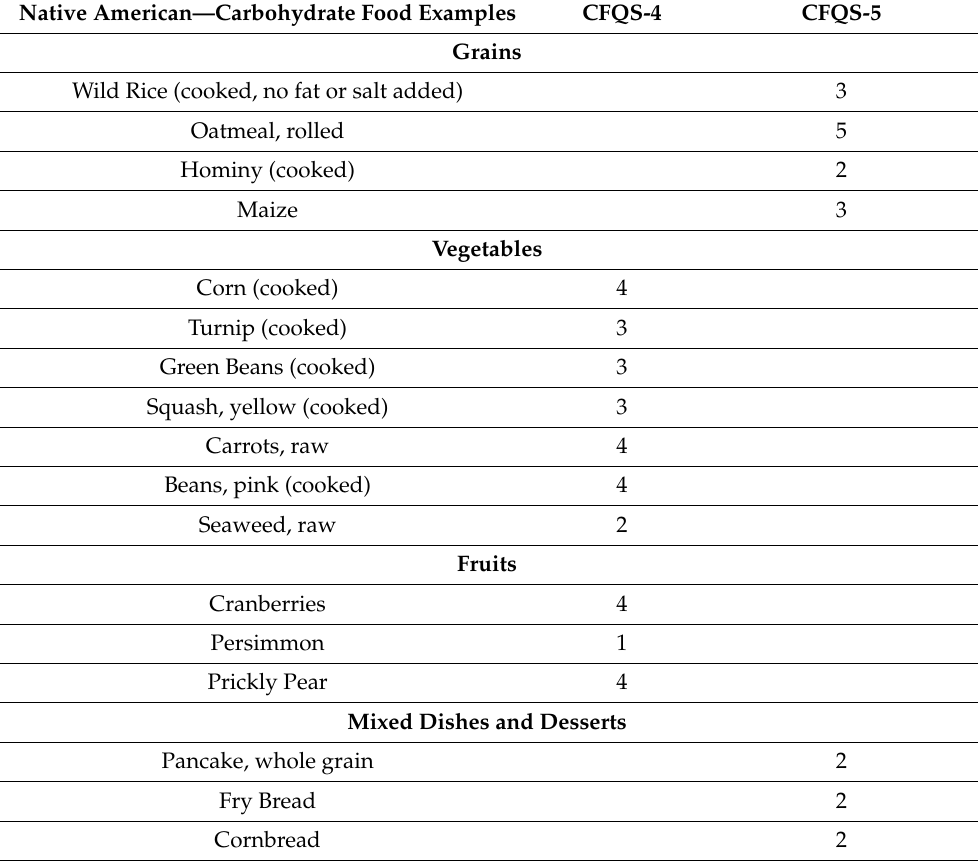
Table 5. CFQS Models Applied to Native American Culturally Inclusive Dietary Patterns. Native American—Carbohydrate Food